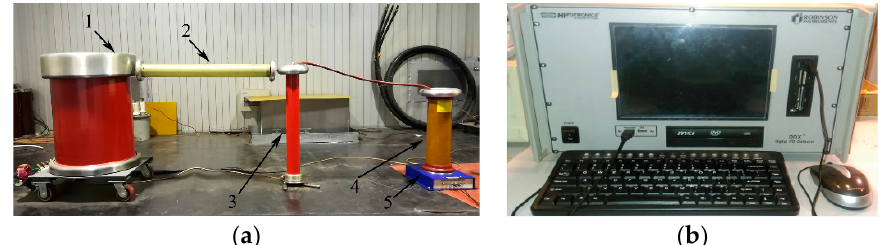
Figure 6. The test system of electrical aging: ( a ) Power frequency test system; ( b ) Partial discharge (PD) detector.